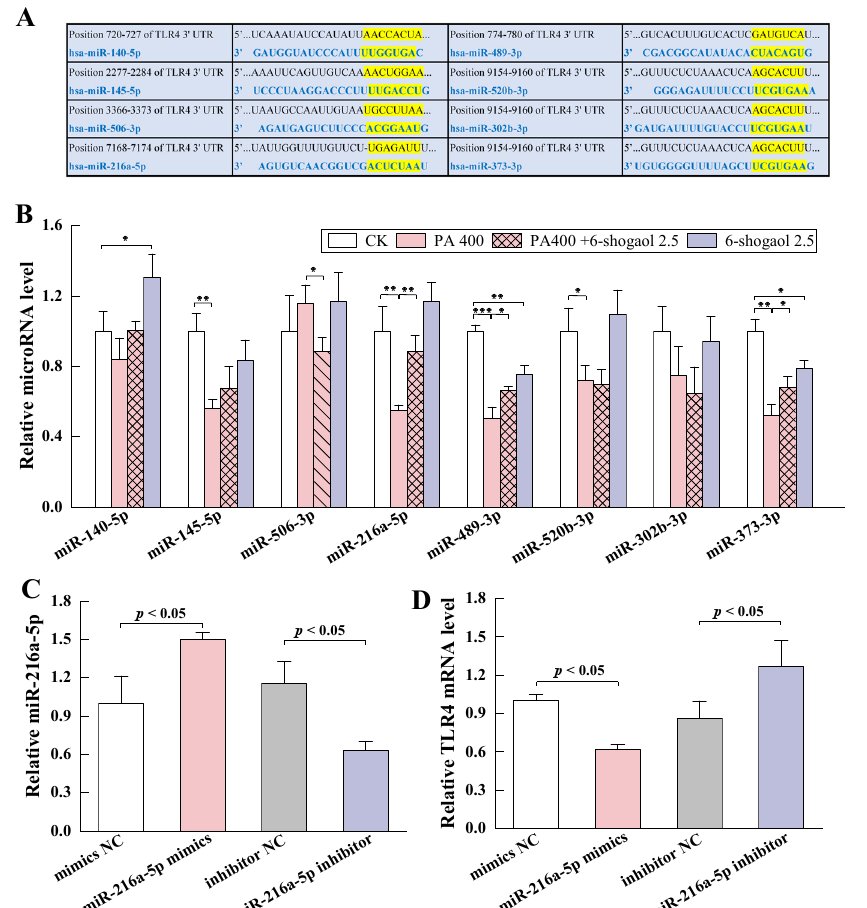
Figure 6. MiRNA-216a-5p directly targeted TLR4 mRNA: ( A ) The predicted TLR4-targeting miRNAs and their binding sites to the 3 ′ -untranslated region (3 ′ UTR) of TLR4; ( B ) Relative levels of the predicted miRNAs in Caco-2 cells treated with 6-shogaol in the presence and absence of PA; ( C ) Relative expression of miR-216a-5p in Caco-2 cells transfected with miR-216a-5p mimics or inhibitor; ( D ) Effects of miR-216a-5p on the level of TLR4 mRNA. Data are given as means ± standard deviations (n = 3). * p < 0.05, ** p < 0.01, *** p < 0.001.